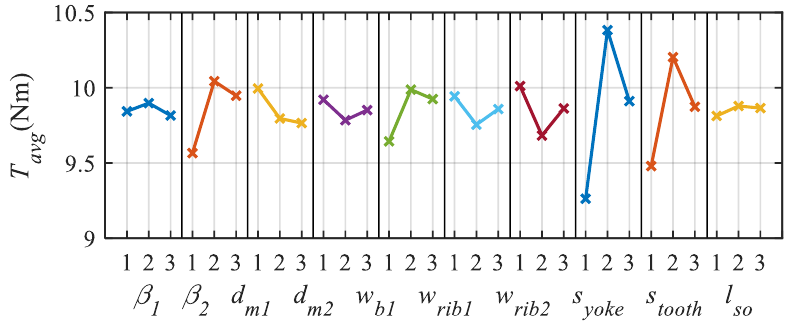
Figure 11. Plot of main factor effects on average torque ( T avg ).